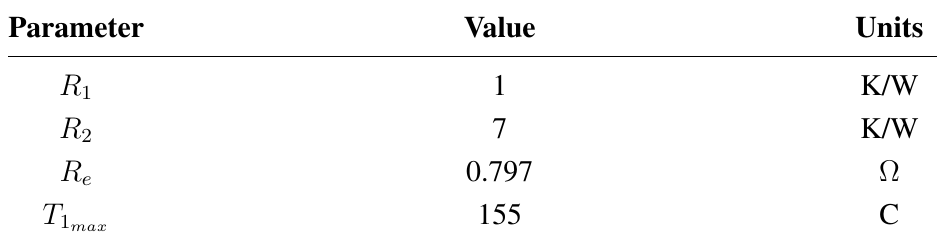
Table 2. Maxon EC22 100-W datasheet thermal